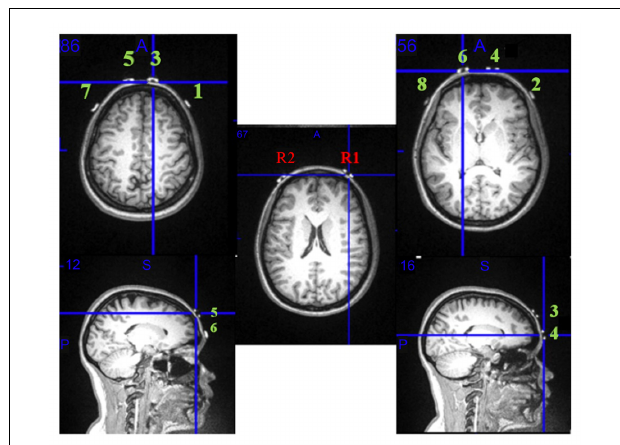
FIGURE 3 | fNIRS optode configuration mapped onto an MRI scan. MRI demonstrates that all the optodes and receivers on the fNIRS are positioned over the right and left Brodmann area 10. R1 and R2 represent detectors; the green numbers 1 through 8 are the fNIRS infrared light